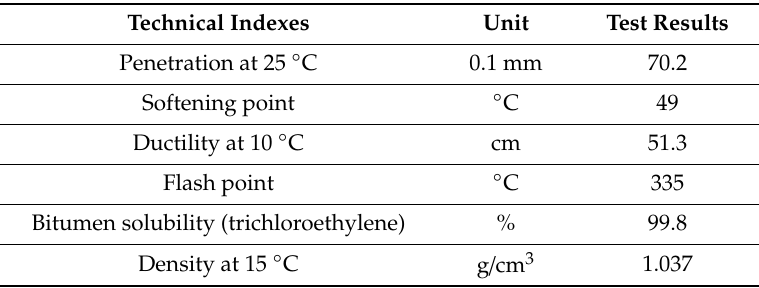
Table 1. Technical indexes of 70# asphalt.